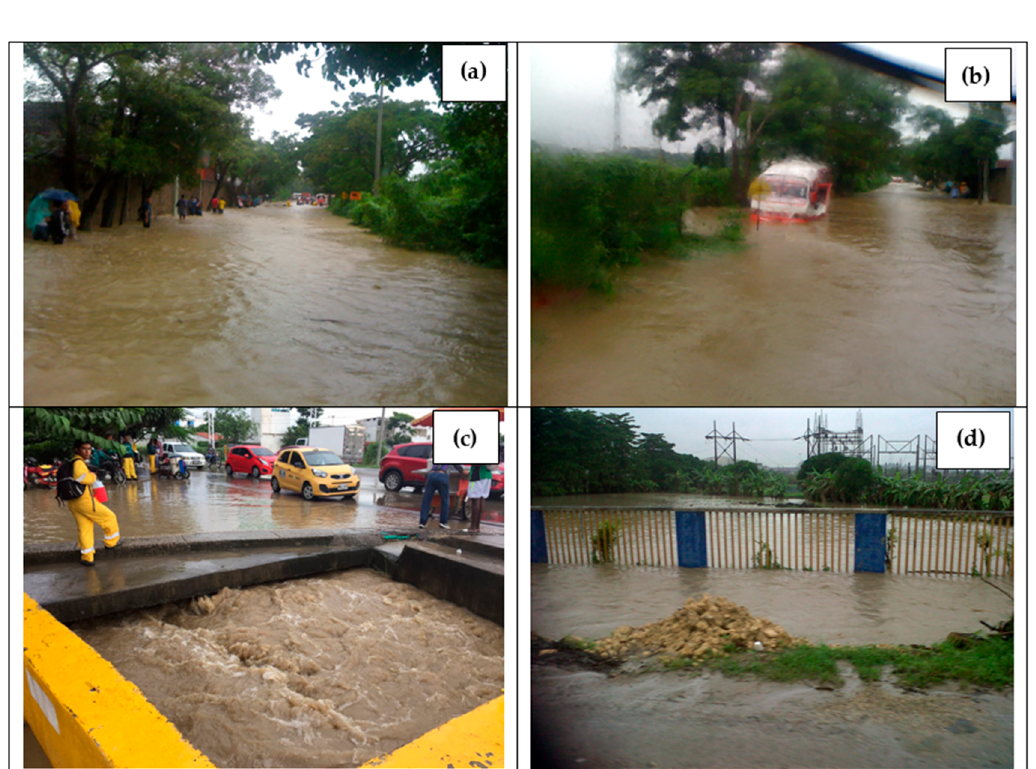
Figure 3. ( a ) Access road to industrial area (2007); ( b ) Bus stranded in flooded area (2007); ( c ) Box-culvert (watershed outlet at cross-section K0+00) (2015); ( d ) Area downstream of the watershed outlet (2010). The locations where the pictures were taken are shown in Figure 2.